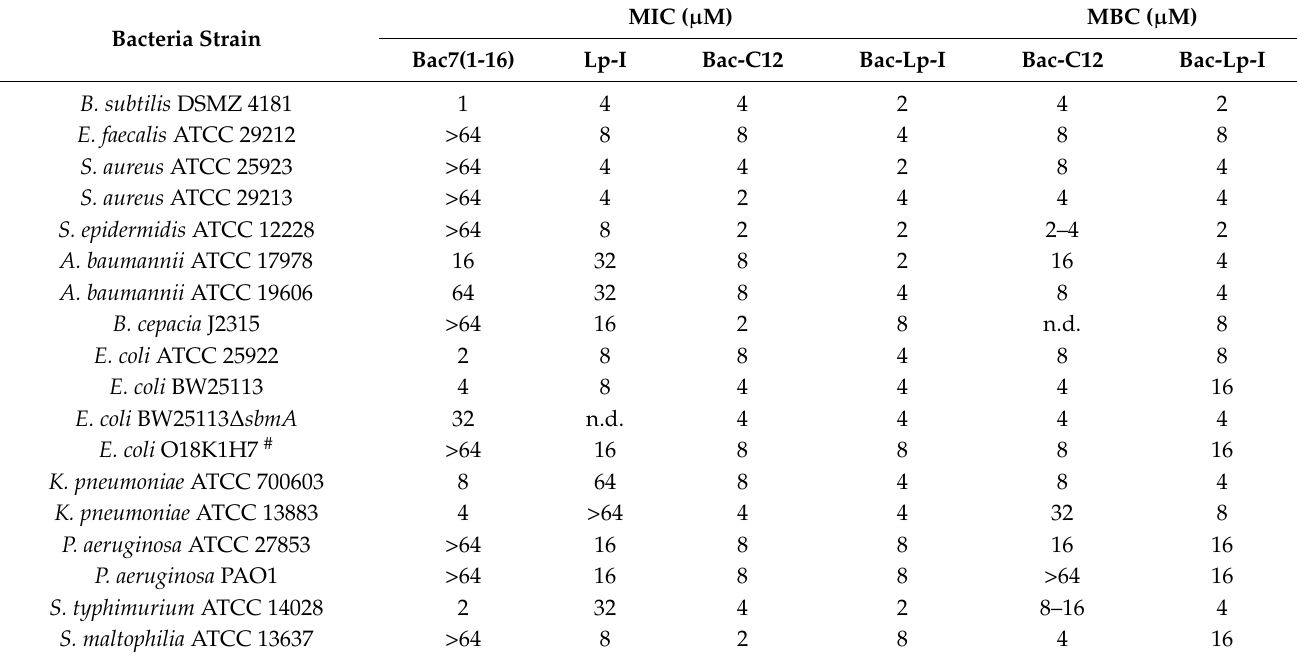
Figure 1. Chemical structures of Bac-C12 (MW: 2244.03) and Bac-Lp-I (MW: 2998.02). 2.2. Antimicrobial Activity of Bac-C12 and Bac-Lp-I We compared the antimicrobial activity of the two different lipidated forms of Bac7(1-16) with that of the original peptides Bac7(1-16) and Lp-I against a panel of Gram-positive and Gram-negative reference strains and against a clinical isolate of Escherichia coli O18K1H7 (Table 1). In general, both Bac-C12 and Bac-Lp-I displayed a broadened spectrum of activity against Gram-positive and Gram-negative bacteria and, in most cases, better antimicrobial activity than the original molecules. Table 1. Minimum inhibitory concentration (MIC) and minimal bactericidal concentration (MBC) of lipidated Bac7(1-16) derivatives and their parental